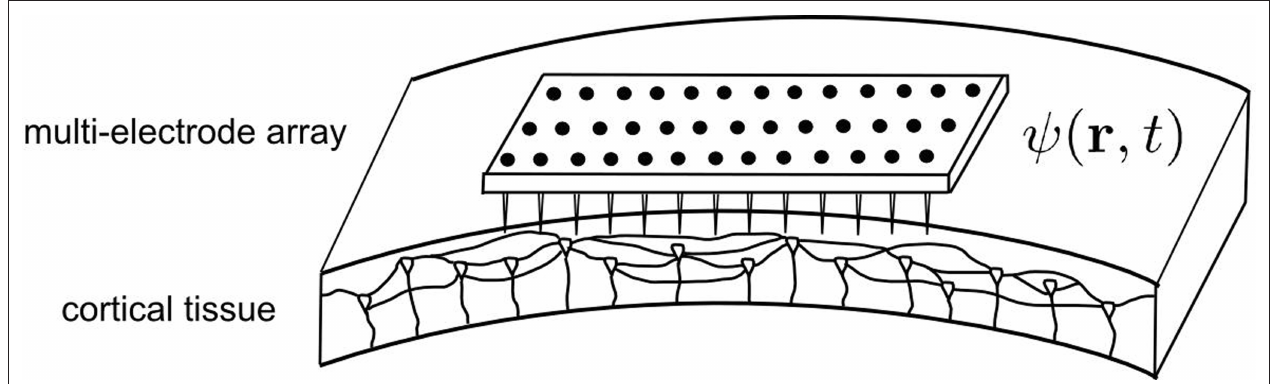
(mesoscopic scale). Consequently, it is possible to exploit the neural field theory to process multi-site recordings provided by the MEA, and to combine these recordings into multiple stimulation signals aiming to modulate neuronal activity.